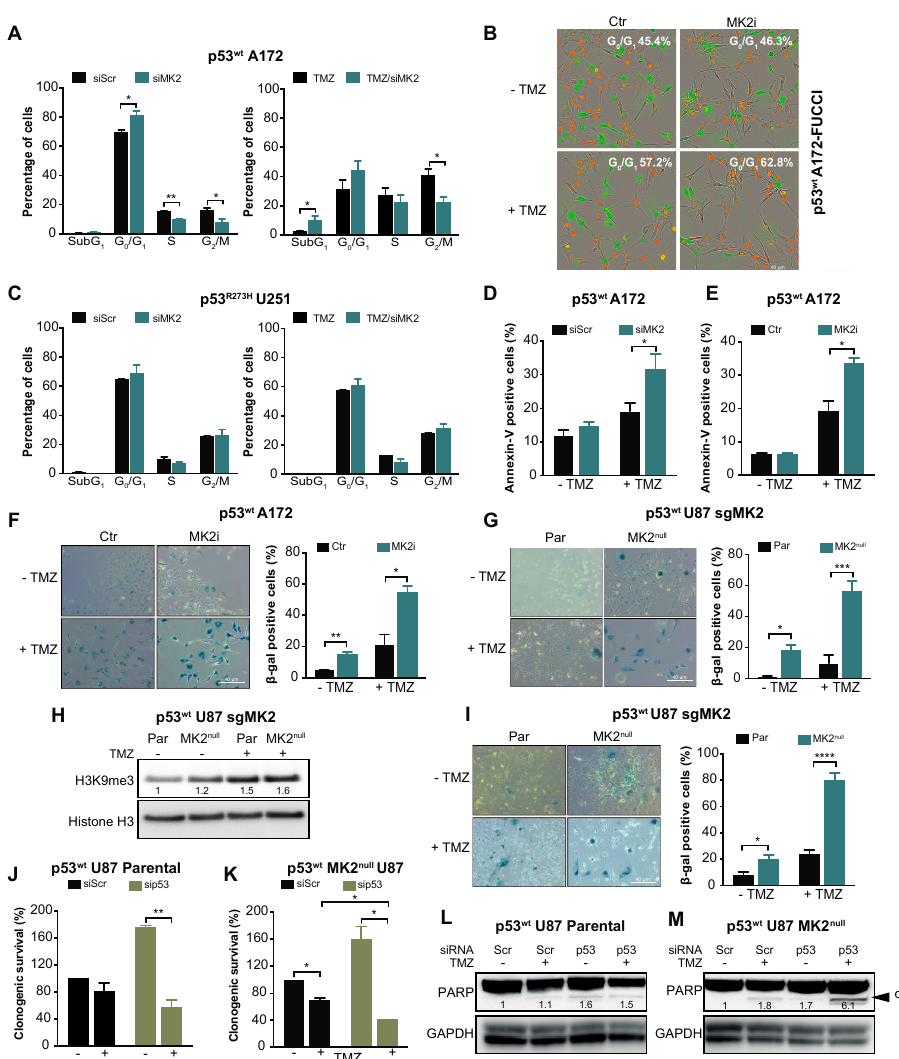
Figure 3. MK2 inhibition induces senescence and apoptosis in p53 wt glioblastoma cells. ( A ) Scramble (Scr) or MK2 siRNA transfected cells were treated with temozolomide (TMZ, 50 µ M, 72 hr) and PI staining analyzed by flow cytometry. ( B ) Cells were treated with MK2 inhibitor IV (MK2i, 1.5 µ M) and temozolomide (10 µ M, 96 hr) and quantification of G 0 / G 1 (red cells) was performed with IncuCyte S3. ( C ) Scramble or MK2 siRNA transfected cells were treated with temozolomide (50 µ M, 72 hr) and PI staining analyzed by flow cytometry . ( D ) Scramble or MK2 siRNA transfected cells were treated with temozolomide (25 µ M, 10 days) and Annexin-V staining analyzed by flow cytometry. ( E ) Cells were treated with MK2 inhibitor IV (1.5 µ M) and temozolomide (25 µ M, 10 days) and Annexin-V staining analyzed by flow cytometry. ( F ) A172 cells were treated with MK2 inhibitor IV (1.5 µ M) and temozolomide (25 µ M, 10 days) and stained for β -galactosidase ( β -gal). ( G ) U87 Parental (Par) and MK2 null (clone C) cells were treated with temozolomide (25 µ M, 10 days) and stained for β -galactosidase. ( H ) Parental and MK2 null (clone C) cells were treated with temozolomide (25 µ M, 10 days) and lysates immunoblotted against indicated antibodies. ( I ) Parental and MK2 null (clone C) cells were treated with temozolomide (25 µ M, 20 days) and stained for β -galactosidase. ( J , K ) Parental and MK2 null (clone C) cells were transfected with scramble or p53 siRNA, treated with temozolomide (25 µ M) and colonies quantified after 12 days of treatment. ( L , M ) Parental and MK2 null (clone C) cells were transfected with scramble or p53 siRNA, treated with temozolomide (25 µ M, 7 days) and lysates immunoblotted against indicated antibodies. All immunoblot including band intensities and microscopic images are representatives of 3 independent experiments. Bar graphs represent mean ± SEM from 3 independent experiments (* p < 0.05; ** p < 0.01; *** p < 0.001; **** p < 0.0001; paired t